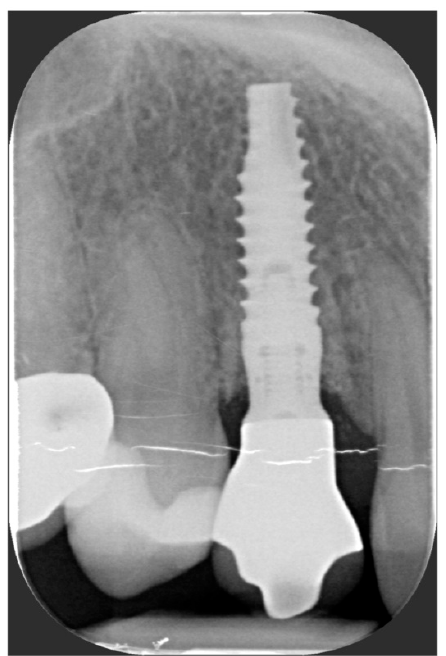
Figure 16. Marginal bone loss evaluated with periodical X-ray scans was minimal.